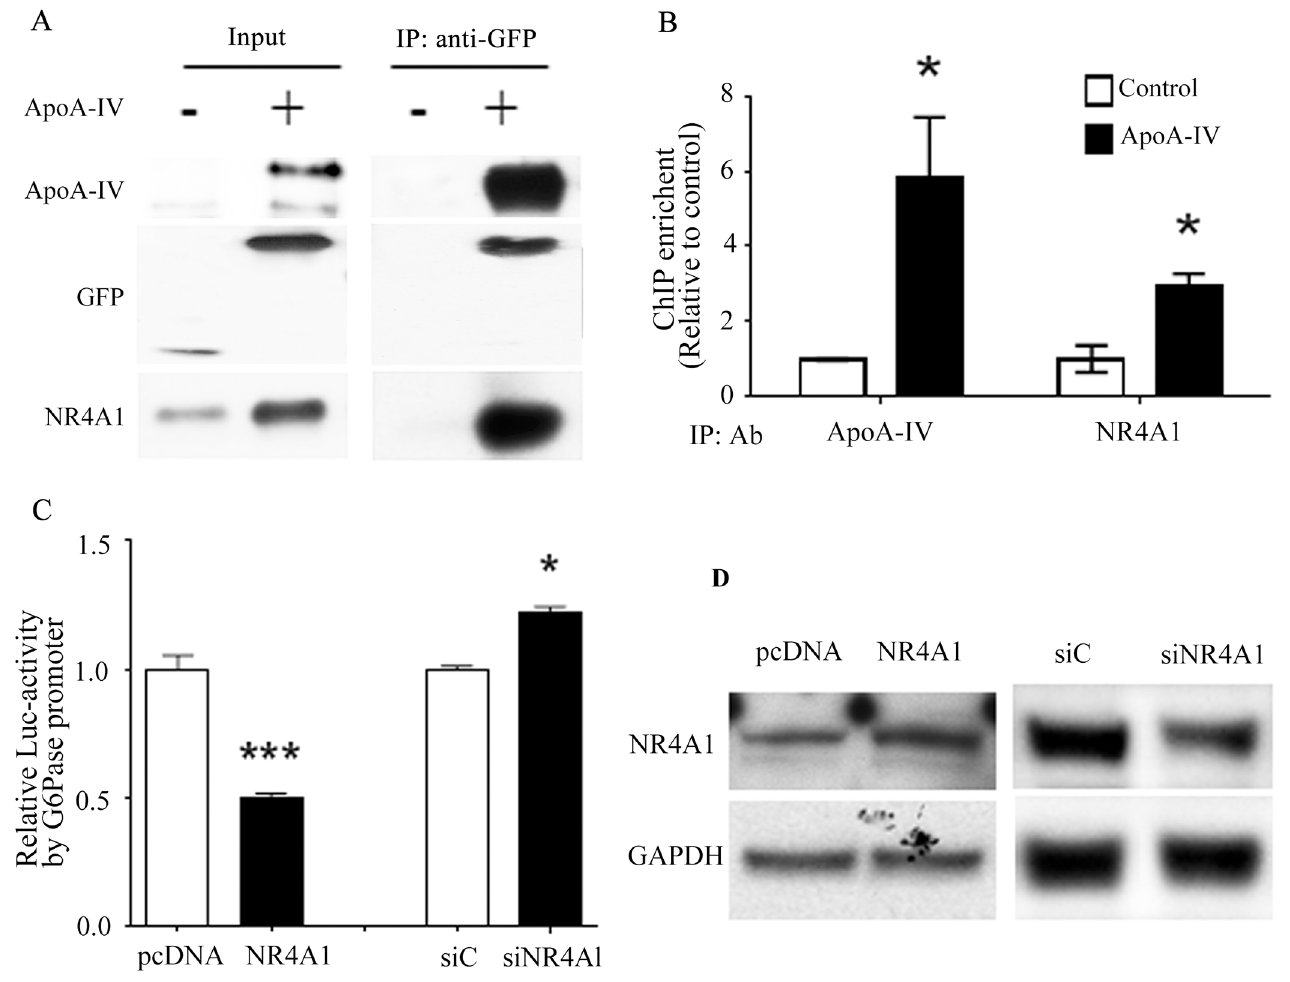
Fig 2. Effect of NR4A1 on the ApoA-IV-mediated regulation of G6Pase promoter activity. (A) HepG2 cells were treated with r-h-apoA-IV-GFP or GFP (control) for 6 h. Nuclear proteins were extracted from the cells, and immunoprecipitation was performed using an anti-GFP antibody. The precipitates were analyzed for the presence of ApoA-IV-GFP and NR4A1 by western blotting. (B) The colocalization of exogenous ApoA-IV and endogenous NR4A1 at the human G6Pase promoter was detected using ChIP. HepG2 cells were treated as described above for coimmunoprecipitation. Immunoprecipitation was performed using anti-NR4A1 and anti-apoA-IV antibodies. Primers were used to amplify the RORE sequence in the human G6Pase promoter or the GAPDH promoter (control) by PCR. The mean ± SE of three samples is shown ( * P < 0.05 vs. vehicle control). (C) The effect of NR4A1 on G6Pase transcription in HEK-293 cells was examined using a luciferase reporter assay. HEK-293 cells were transfected with the G6Pase -luciferase reporter plasmid, human NR4A1 plasmid, renilla luciferase control reporter plasmid, and siNR4A1, control siRNA, or an equivalent volume of solvent for 24 h. Cells were also transfected with the G6Pase-luciferase and renilla luciferase reporter plasmids and the pcDNA3.1 plasmid as a control. The transfected cells were treated with recombinant human ApoA-IV protein or vehicle control for 24 h, and relative luciferase activity was measured. Relative luciferase activities (right) are presented as the mean ± SE of at least three samples from three independent experiments ( *** P < 0.001 vs. pcDNA or siC controls). (D) Western blotting of cells transfected with the pcDNA plasmid and no siRNA (pcDNA), cells transfected with the NR4A1 expression plasmid and no siRNA (NR4A1), cells cotransfected with the control siRNA (siC), and cells cotransfected with the siNR4A1 (siNR4A1).